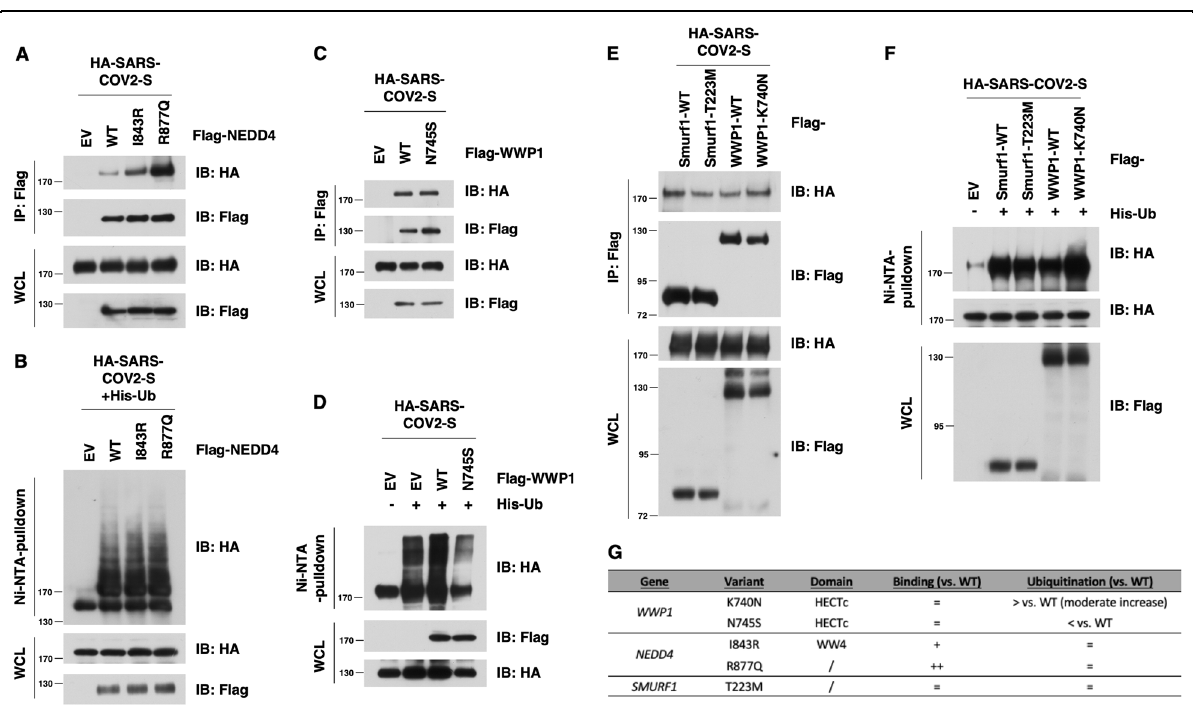
I3C on the cytopathic effect (CPE) induced by SARS- CoV-2 infection in Vero E6 cells. We treated the cells with I3C using a 3-fold concentration scale ranging